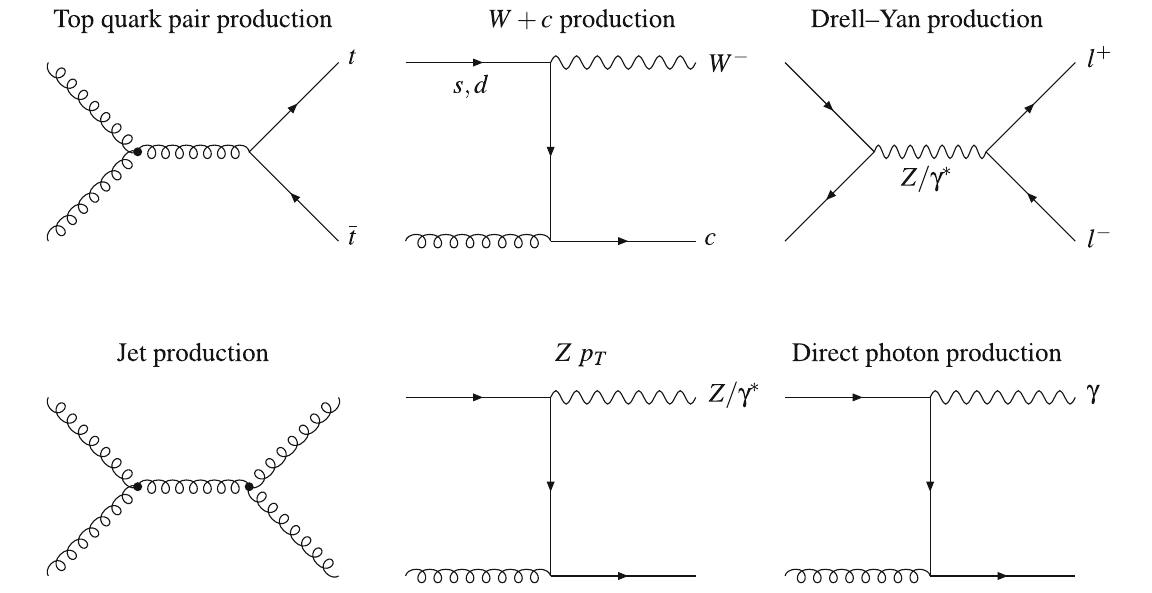
Fig. 1 Representative Feynman diagrams at the Born level of the six types of collider processes for which HL–LHC pseudo–data has been generated in this analysis: the production of top quark pairs, W bosons